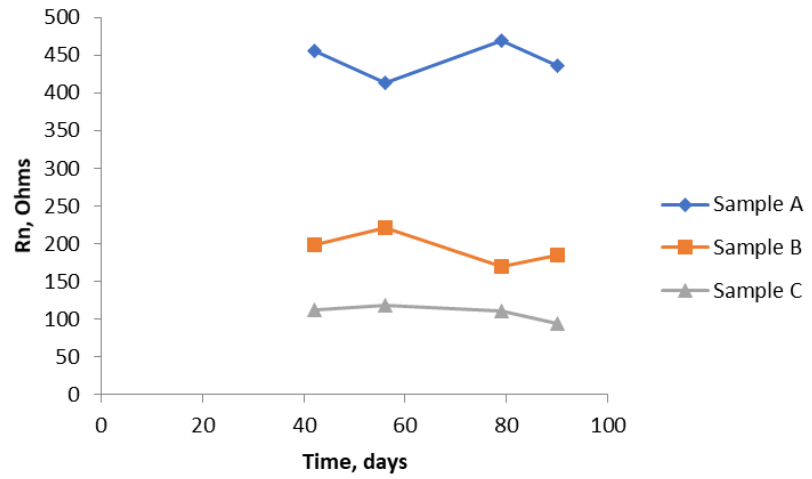
Figure 14. R n results using NOCS arrangement for all three samples.